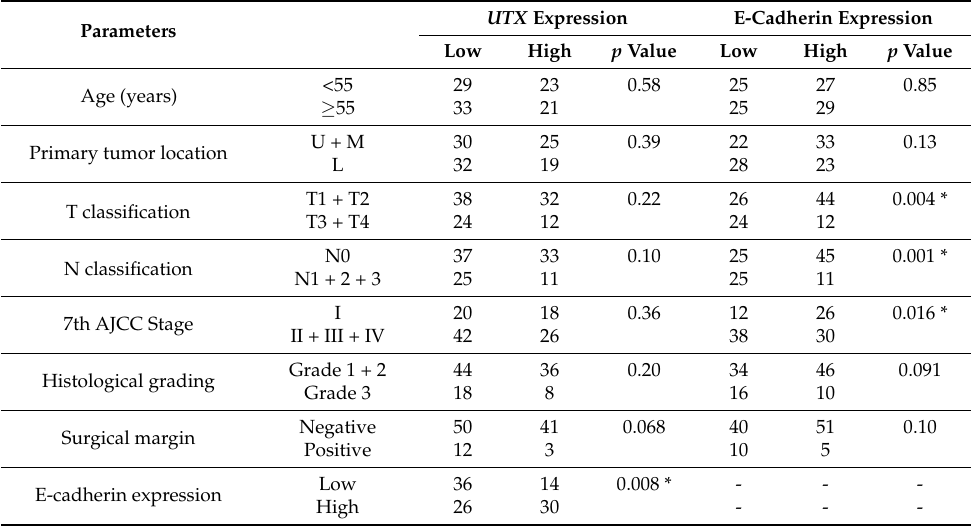
Table 2. Associations between UTX expression and clinicopathological parameters in 106 patients with ESCC receiving esophagectomy.